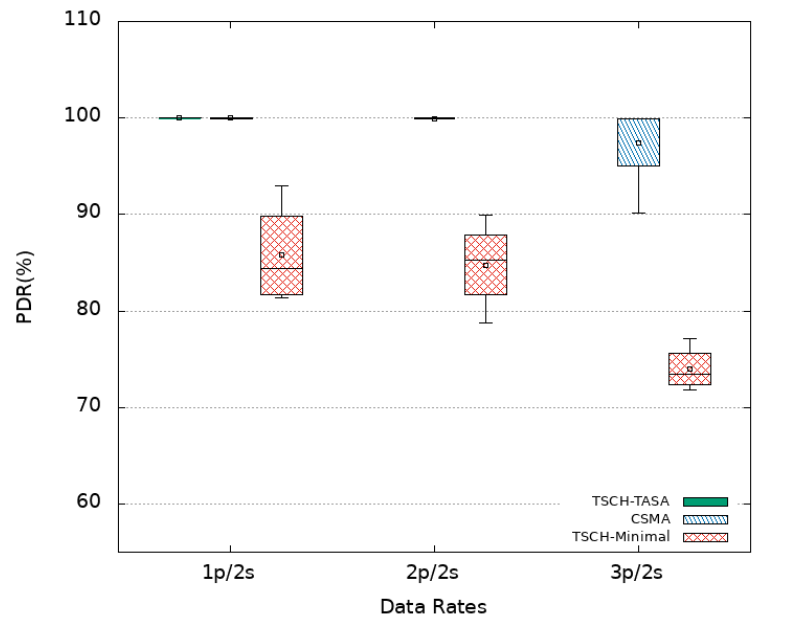
Figure 6. PDR results.